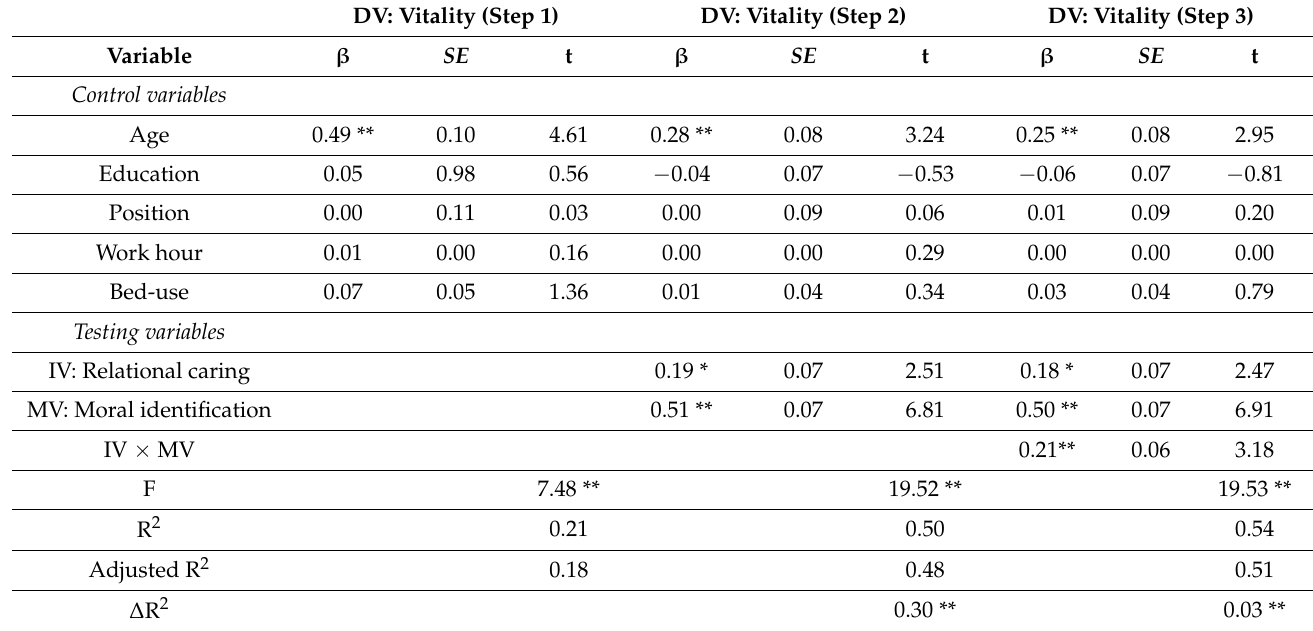
Table 4. The moderation effect of moral identification under the condition of 40 and below work hours.